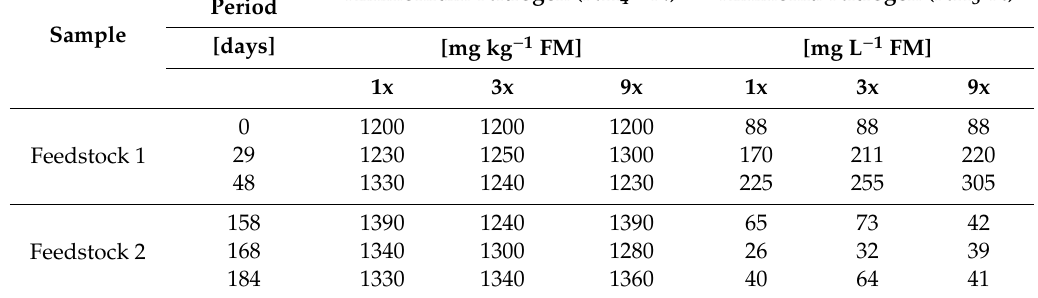
Table 5. Contents of ammonium-nitrogen (NH 4 + -N) and ammonia-nitrogen (NH 3 -N) of the anaerobic digestion from the three di ff erent feeding strategies. The samples were collected and analysed during the measurement period from both feedstocks (feedstock 1: 1x: n = 12, 3x,9x: n = 18; feedstock 2: 1x, 9x: n = 12, 3x: n =